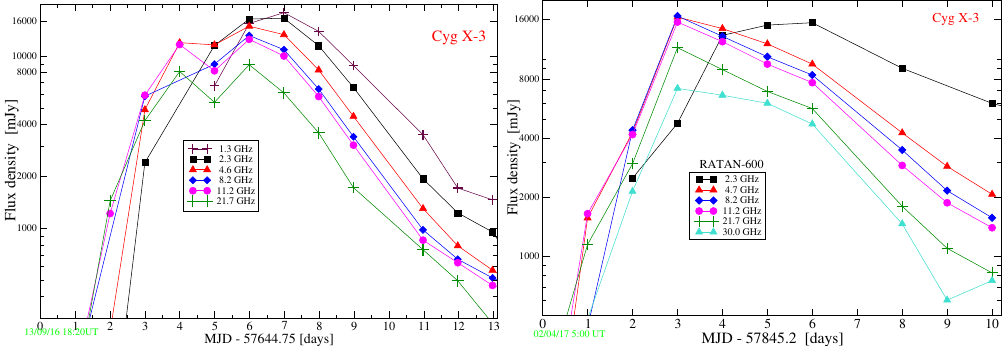
Figure 4. Evolution of the first giant flare ( left ), counted from its start on 13 September 2016, and the second one ( right ), counted from its start on 1 April